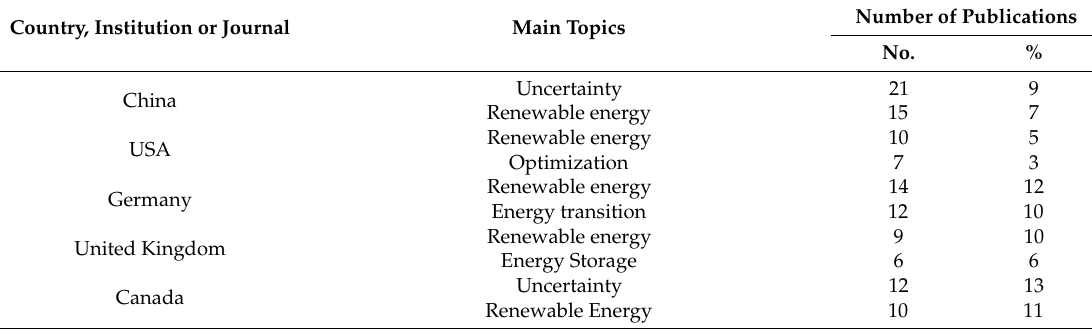
Table 11. Most important topics in publications on municipal energy system planning in the top five relevant countries, institutions and journals. The percentage values refer to the total number of publications of the respective country, institution or